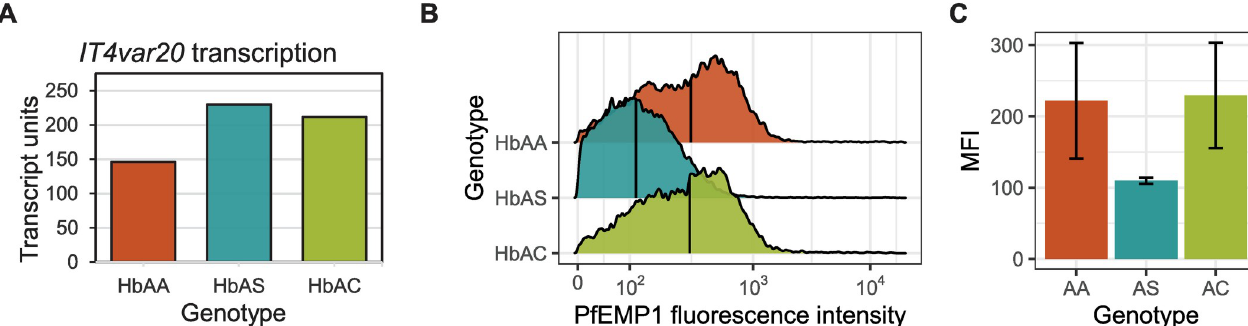
Fig 4. Effects of sickle-trait hemoglobin on transcript and surface protein expression of IT4var20 PfEMP1. A) Quantitative PCR of IT4var20 transcription in HbAA, HbAS, and HbAC converted to Transcript units relative to seryl-tRNA synthetase housekeeping gene (n = 1). B) Histogram of IT4var20 PfEMP1 expression from a representative flow cytometry experiment. The PfEMP1 fluorescence intensity was measured from infected HbAA, HbAS, and HbAC RBCs, stained with monoclonal IgG antibody targeting the CIDR α of IT4var20 and APC-conjugated anti-mouse IgG. The median flourescence is marked with a vertical line. C) Summary of the median fluorescence intensity (MFI) from separate flow cytometry experiments (n = 3). Error bars show the standard deviation.